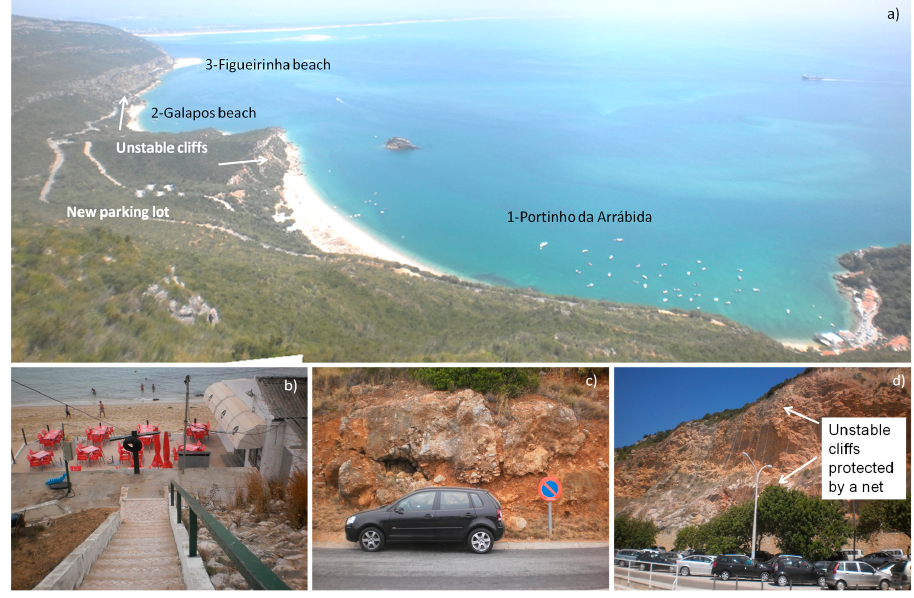
Figure 14. West part of Setubal: ( a ) Location of the main beaches; ( b ) Access to Galapos beach; ( c